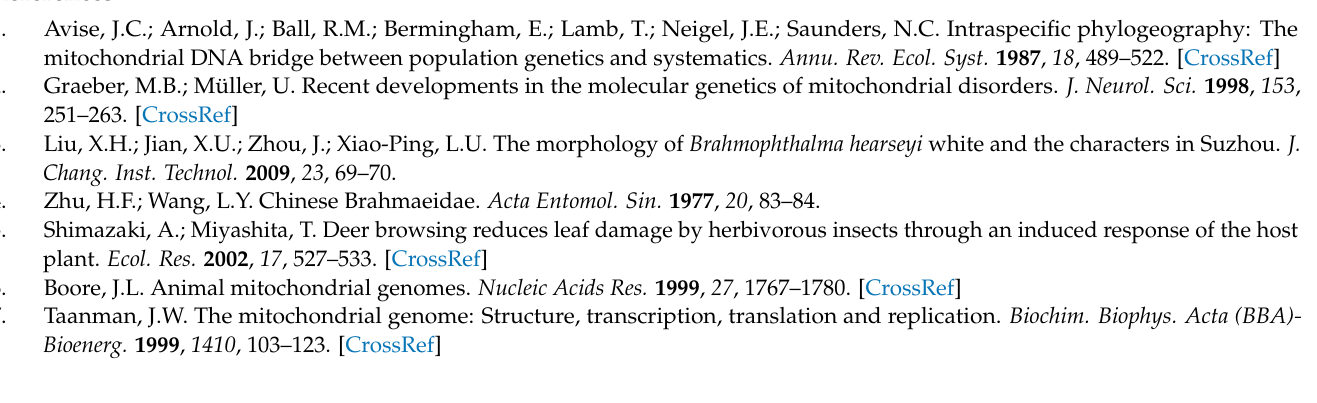
.3390/insects12110973/s1, Figure S1: Predicted secondary structure of the Brahmophthalma hearseyi 2 rRNA genes., Figure S2: Predicted secondary clover-leaf structure of the Brahmophthalma hearseyi 22 tRNA genes. Figure S3: Features of the AT-rich region of Brahmophthalma hearseyi . Table S1: Universal primer sequences and condition of Long-distance PCR used to amply the mitochondrial genome of Brahmophthalma hearseyi , Table S2: Organization of the Brahmophthalma hearseyi mitochondrial genome, Table S3: Nucleotide composition features within Brahmophthalma hearseyi mitochondrial genome Table S4: Codon usage of the protein-coding genes of the Brahmophthalma hearseyi mitogenomes. Table S5: Amino acid composition of 13 proteins of the Brahmophthalma hearseyi mitochondrial